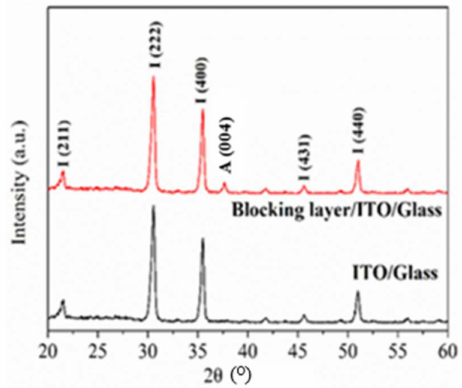
Figure 3. X-ray diffraction patterns of the TiO 2 blocking layer coated on ITO/glass and bare